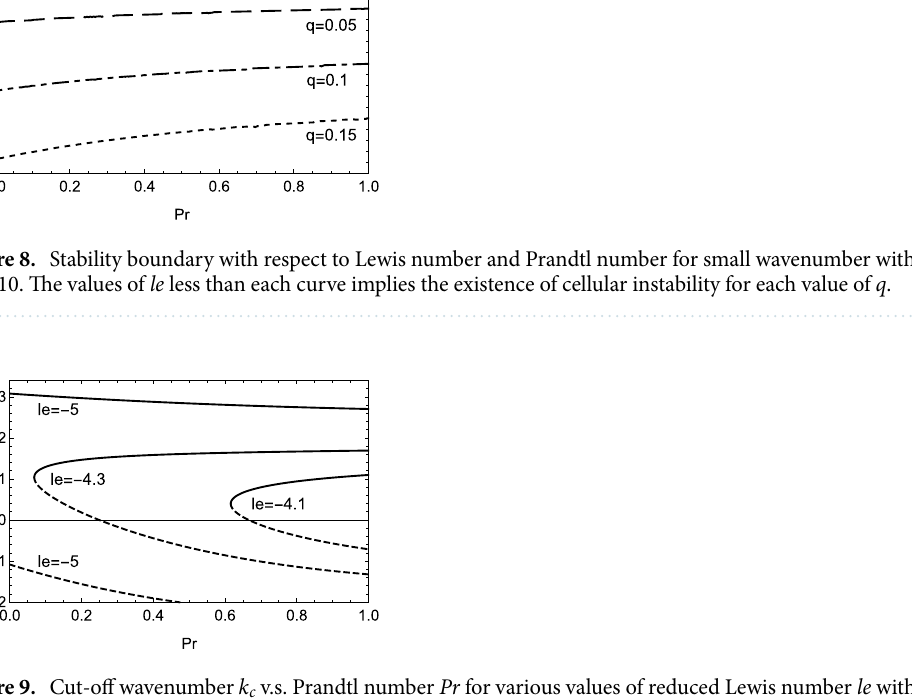
Figure 9. Cut-off wavenumber k c v.s. Prandtl number Pr for various values of reduced Lewis number le with 0.1 . The solid and dashed lines reflect the signs in 10 and q β = =